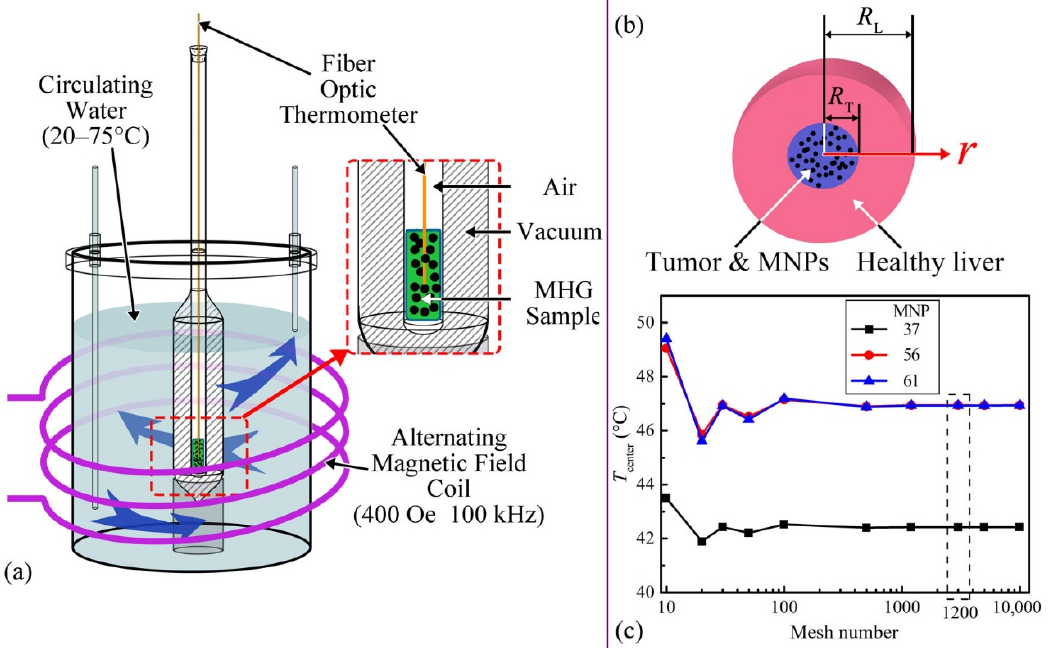
Figure 1. ( a ) Experimental setup of calorimetry experiments; ( b ) Tissue model of the thermal simulations, R T is the radius of the sphere tumor, R L is the radius of the healthy liver tissue; ( c ) Convergence analysis of mesh number about the final temperatures of tumor center ( T center ), with 1200 as the chosen mesh number.